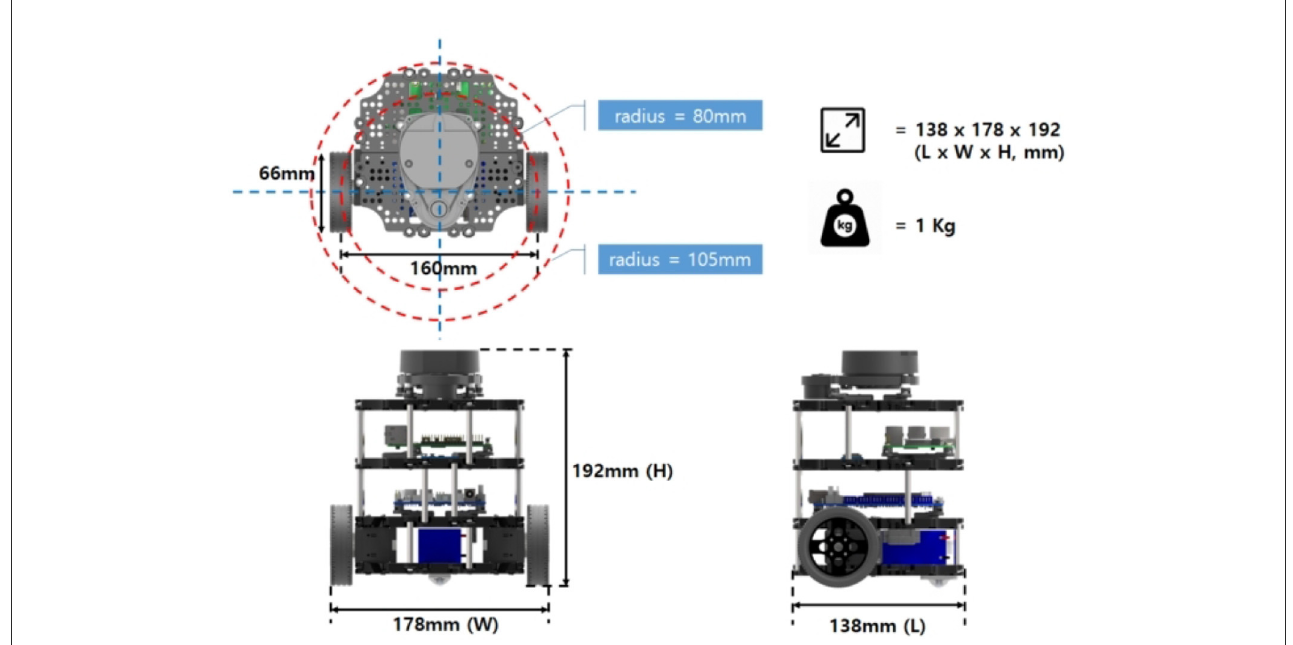
FIGURE9 Turtlebot3 Burger model dimensions. Taken from Robotis